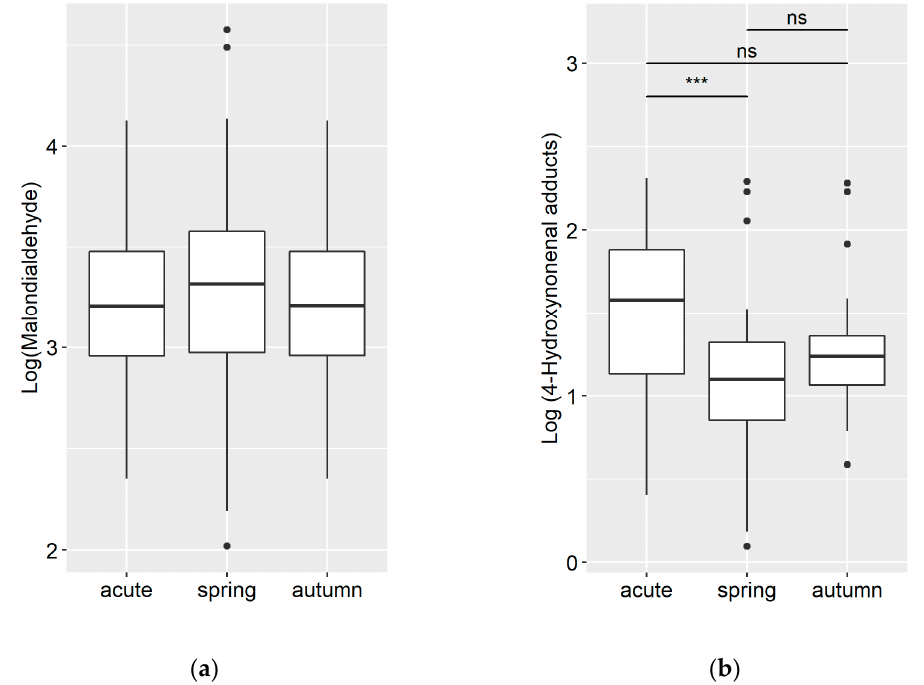
Figure 2. ( a ) MDA concentrations, μ mol/L, and ( b ) 4-HNE adducts concentrations, μ g/L, in blood plasma of acutely ill COVID-19 patients (acute) and in post-COVID-19 disease patients 2 months following their discharge from the hospital: infected with COVID-19 in the spring–early summer period (spring) or in summer–autumn period (autumn). Black dots show not significant outliers. *** p < 0.001;